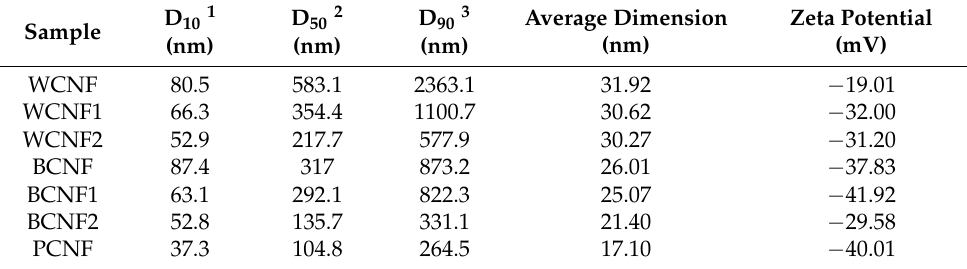
Figure 3. Particle size distribution of the CNFs. ( a ) intensity-size distribution, ( b ) number-size distribution. Table 1. Particle size distribution and zeta potential of the CNFs.